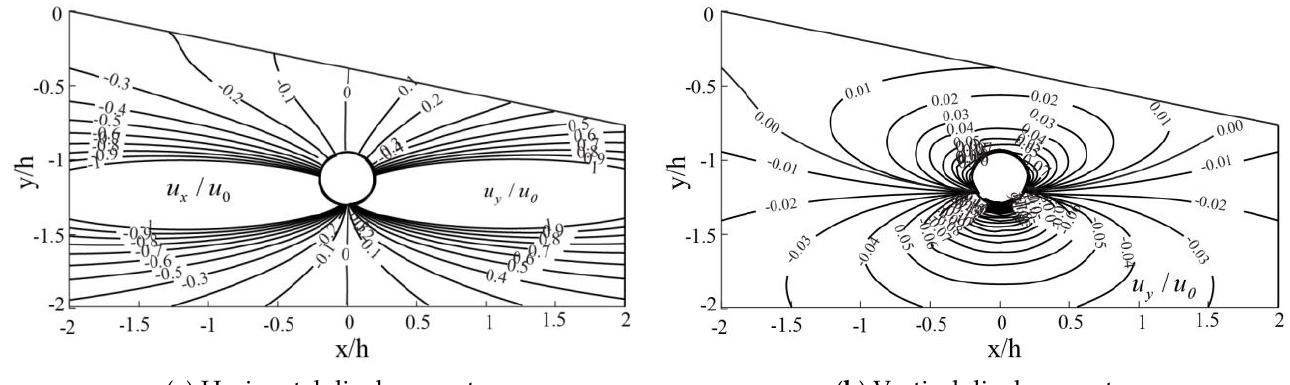
Figure 6. Stratigraphic displacement of the tunnel wall (uniform convergence).